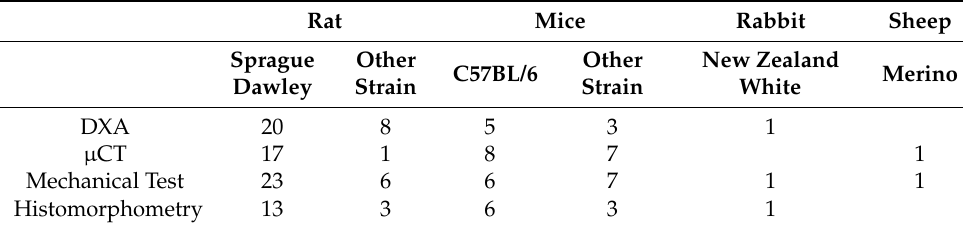
Table 8. Number of studies by species and strain using bone measurement